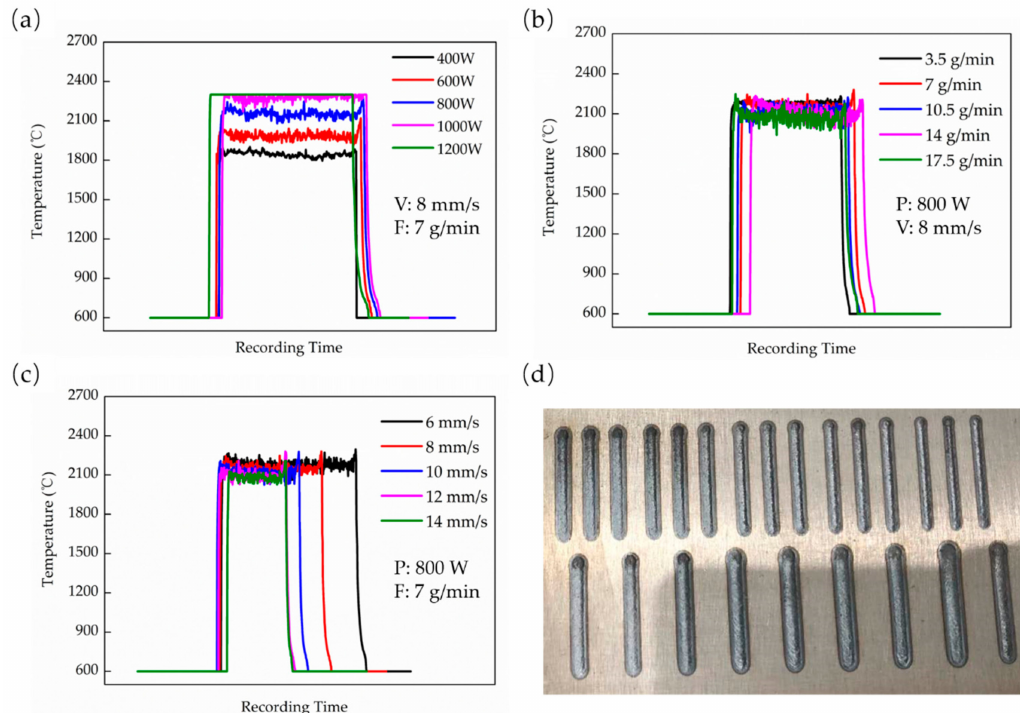
Figure 3. The e ff ects of di ff erent process parameters: ( a ) laser power (P), ( b ) powder feed rate (F), and ( c ) scanning speed (V) on the molten pool temperature and ( d ) the deposited single track